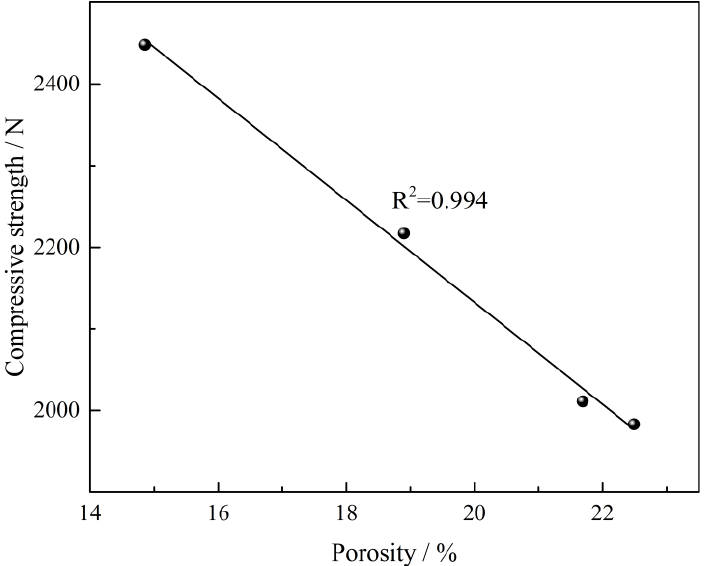
Figure 6. Relationship between porosity and compressive strength of CVTP.